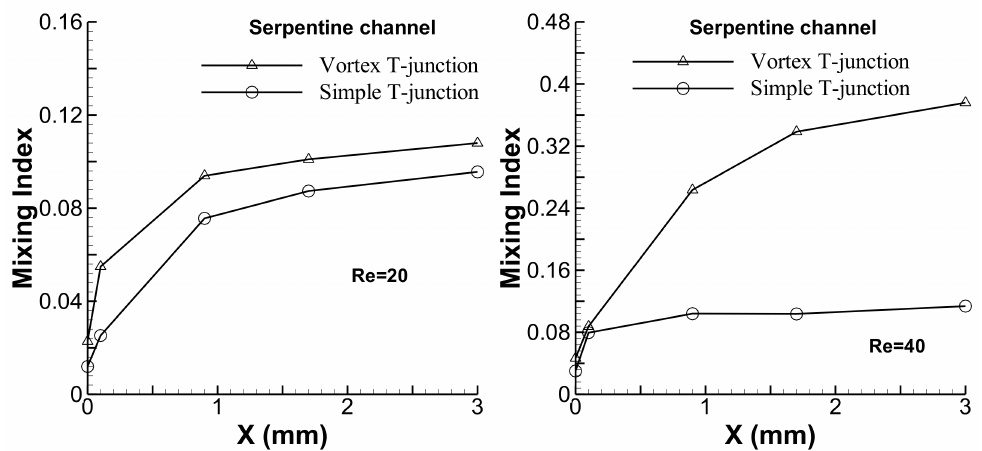
Figure 11. Comparison of the mixing performances of planar serpentine channels integrated with simple and vortex